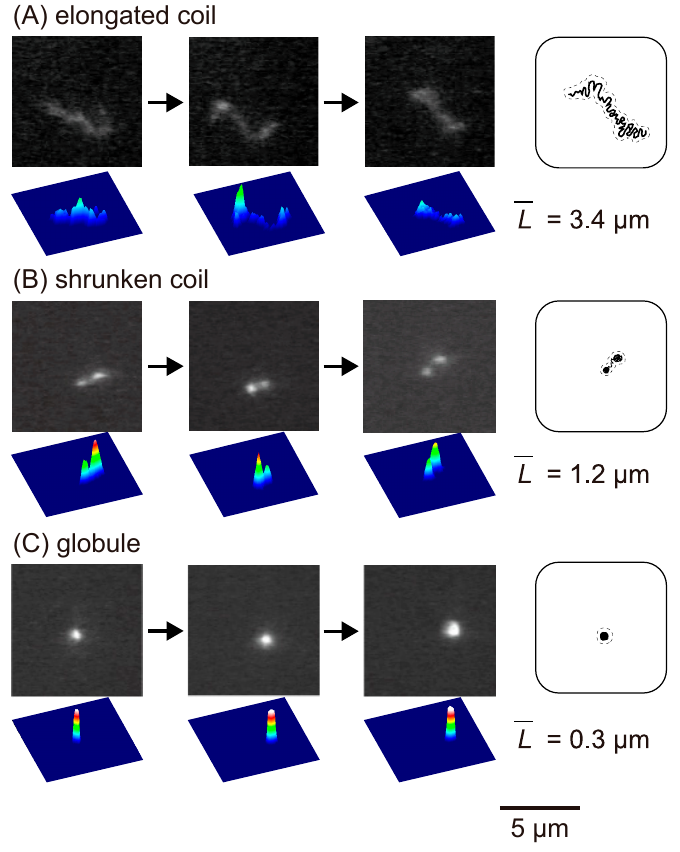
Figure 1. Examples of the fluorescence microscopic (FM) images of single T4 GT7 DNA molecules in bulk solution exhibiting Brownian motion. Corresponding quasi-3D profiles on the spatial fluorescence intensity distribution are also shown. The total observation time is 1 second. ( A ) In the absence of polyamines, ( B ) 50 μ M SPM, and ( C ) 80 μ M SPM. The top row shows fluorescence microscopic images. L is the time-average of the long-axis length. A blurring effect on the order of 0.3 µ m is observed for the FM images.